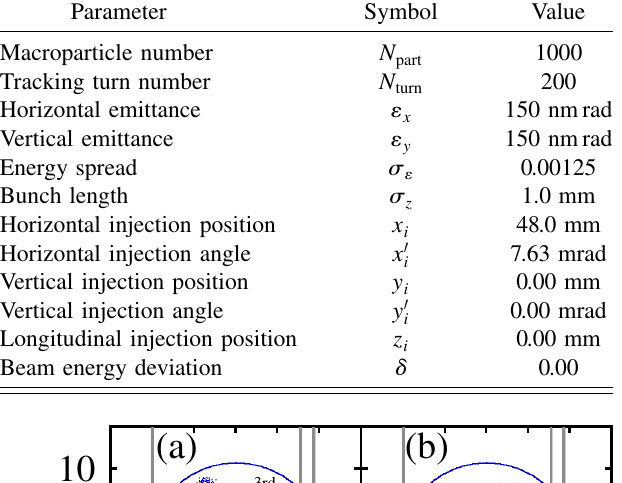
TABLE II. Initial conditions of the injected beam for a multi- particle tracking